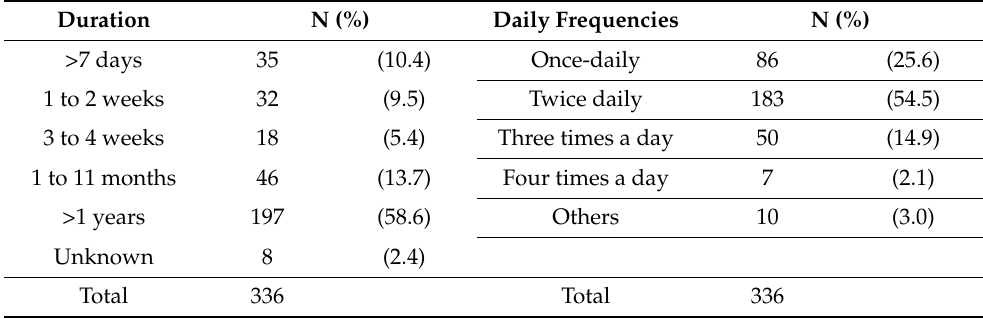
Table 1. The duration and frequencies of each device use.